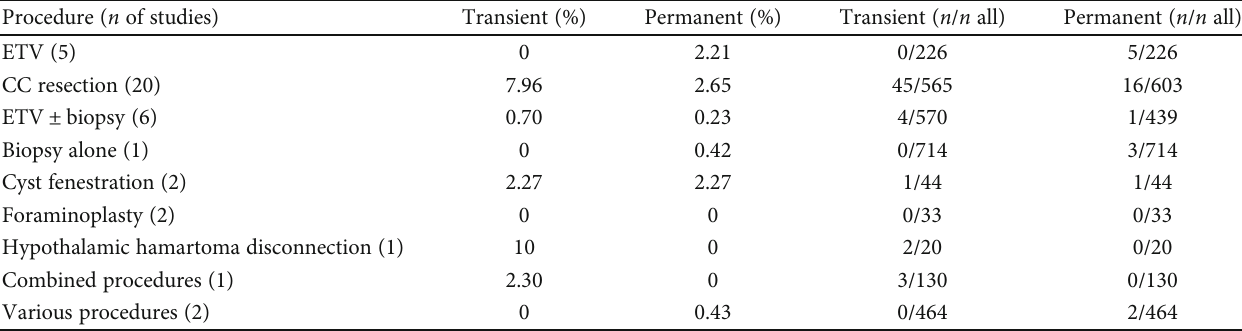
Table 2: Rates of cognitive complications by type of ventricular endoscopic